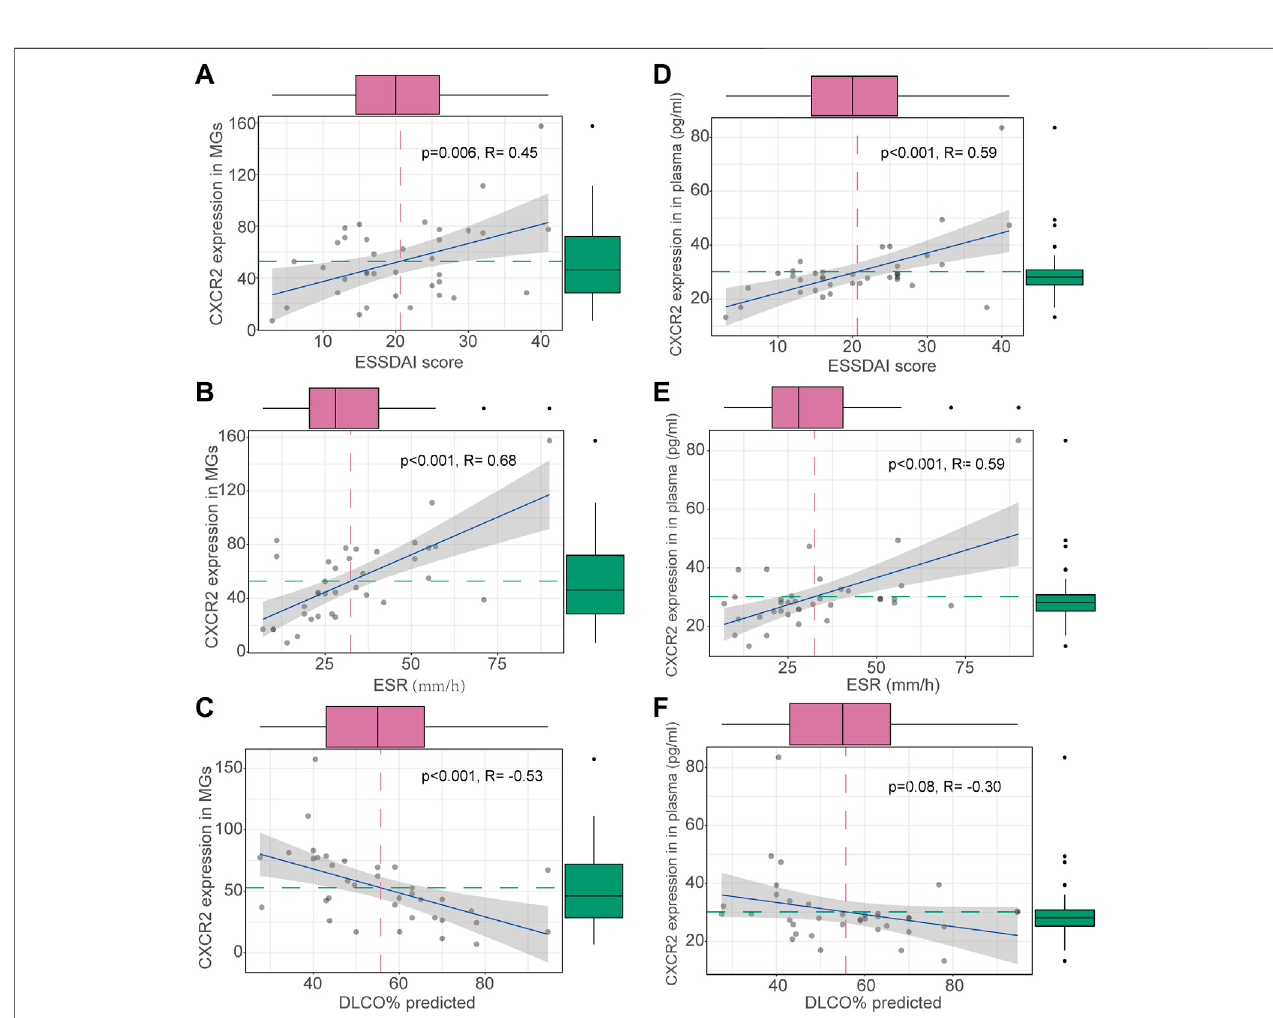
FIGURE 3 | Clinical correlations of CXCR2 expression in patients with ILD-pSS. CXCR2 gene expression in MSG was positively correlated with the ESSDAI score (A) and ESR (B) , and inversely associated with DLCO (C) . CXCR2 gene expression in plasma wassimilarly positively correlated with the ESSDAI score (D) and ESR (E) , and inversely associated with DLCO (F)